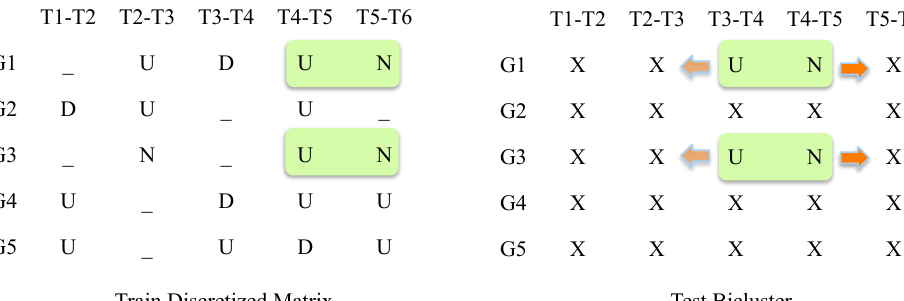
Figure 3: Symbolic comparison between a test bicluster (on the right) and the train discretized expression matrix (on the left). In this case, the highest scoring time-lag is +1 corresponding to shifting the test bicluster one position to the right, where a perfect symbol match is achieved with the symbols shaded green on the left, identifying a delayed expression profile between the